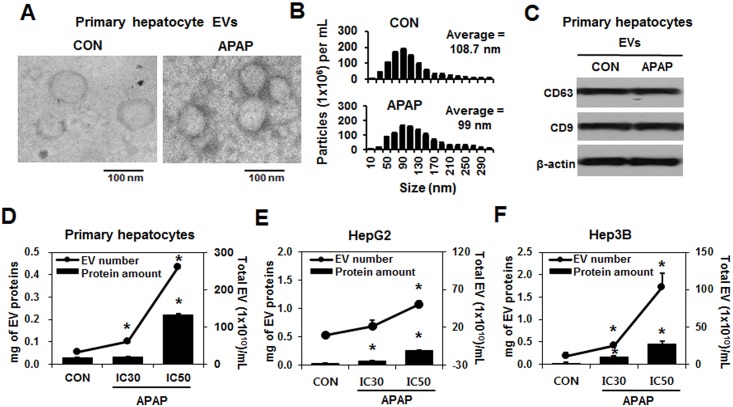
The number and protein content in purified EVs from cultured cells were increased by APAP.Rat primary hepatocytes were exposed to APAP (20 mM APAP) for 24 h (n = 4/group). (A) A representative electron microscopic image of EVs isolated from culture media after primary hepatocytes were exposed to saline (CON) or APAP. (B) Analysis of the size distribution of CON- and APAP-derived EVs. (C) Representative immunoblot analysis of exosome marker proteins in EVs isolated from culture media. (D) Rat primary hepatocytes were exposed to saline (CON), APAP at the IC30 (10 mM APAP), or APAP at the IC50 (20 mM APAP) for 24 h, and the EVs isolated from the conditioned media (n = 10/group). The numbers and protein amounts in isolated EVs were determined by NanoSight analysis and protein quantification, respectively. (E and F) HepG2 and Hep3B cells were treated with APAP (at the IC30 or IC50) for 24 h. EVs were isolated from the conditioned media and analyzed using NanoSight analysis and protein quantification, respectively. *P < 0.05.